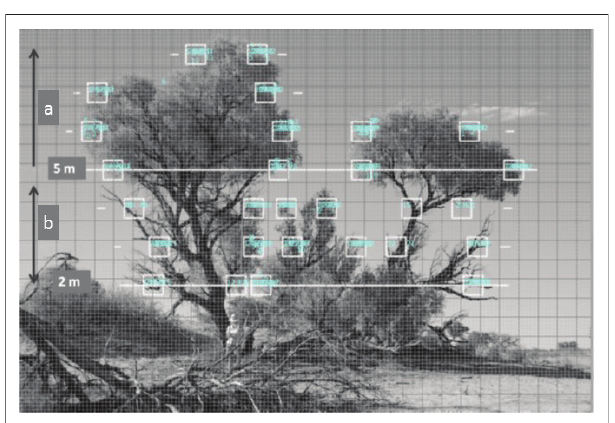
FIGURE 1-A1: An illustration of the grid overlay and intercept counting method used for determining the amount of live or dead canopy material and the number of flowers and pods in the browse range and above browse range.